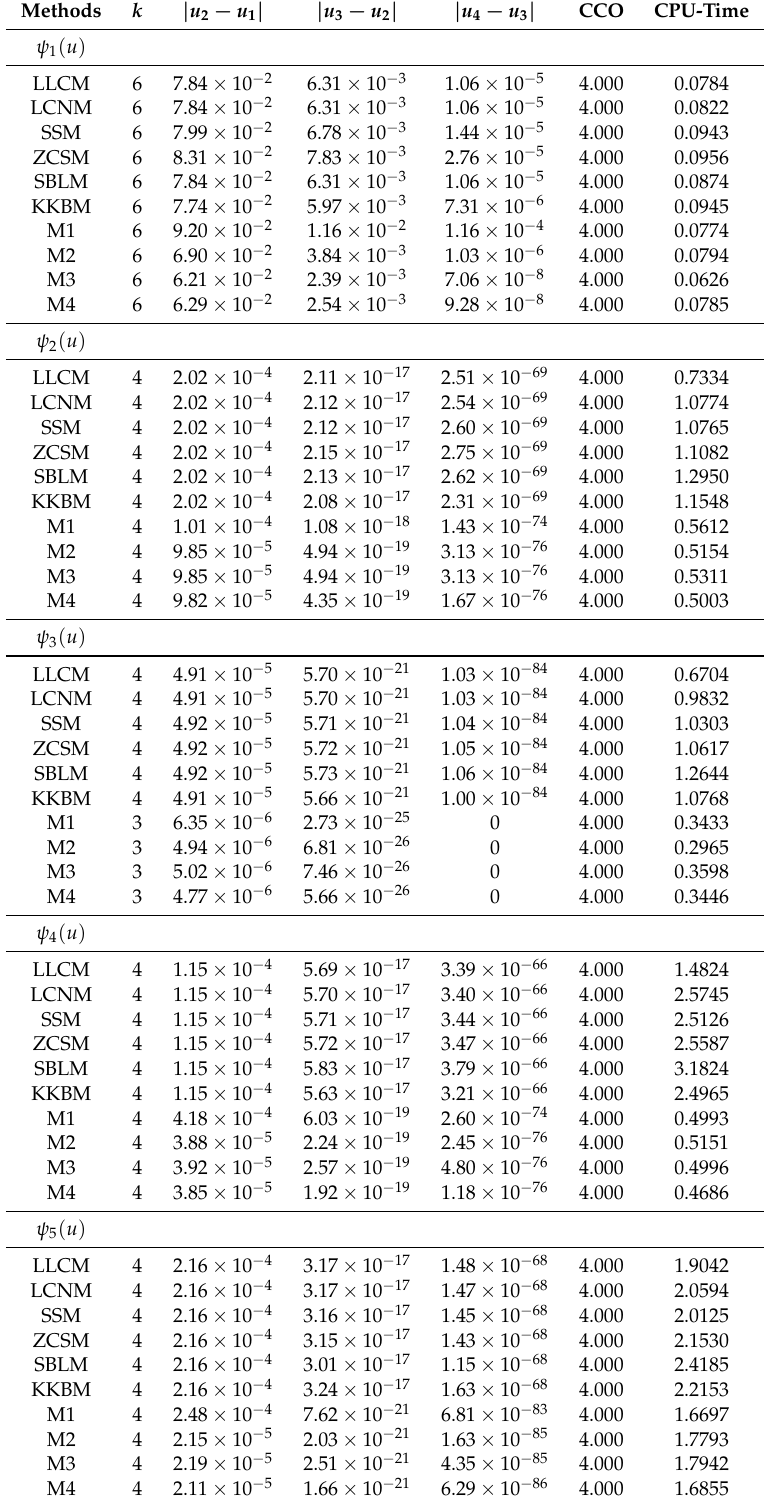
Table 1. Comparison of numerical